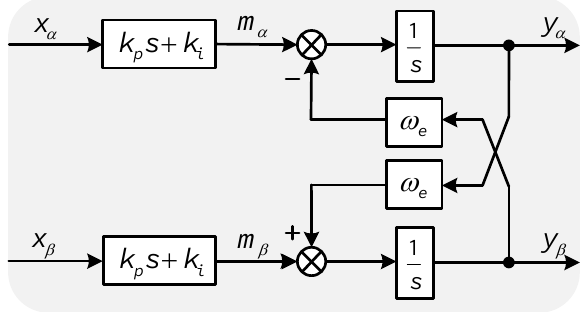
Figure 5. Structure of the proposed D-PCI current controller.